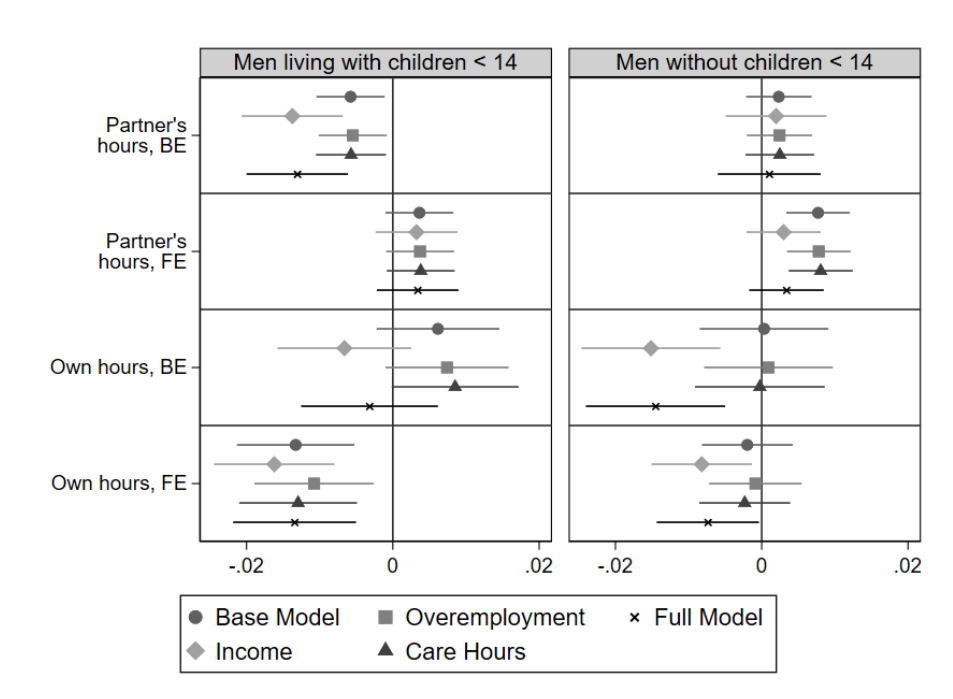
Figure 2 : Own and partner’s work hours coefficient from the hybrid models for men (Cls at